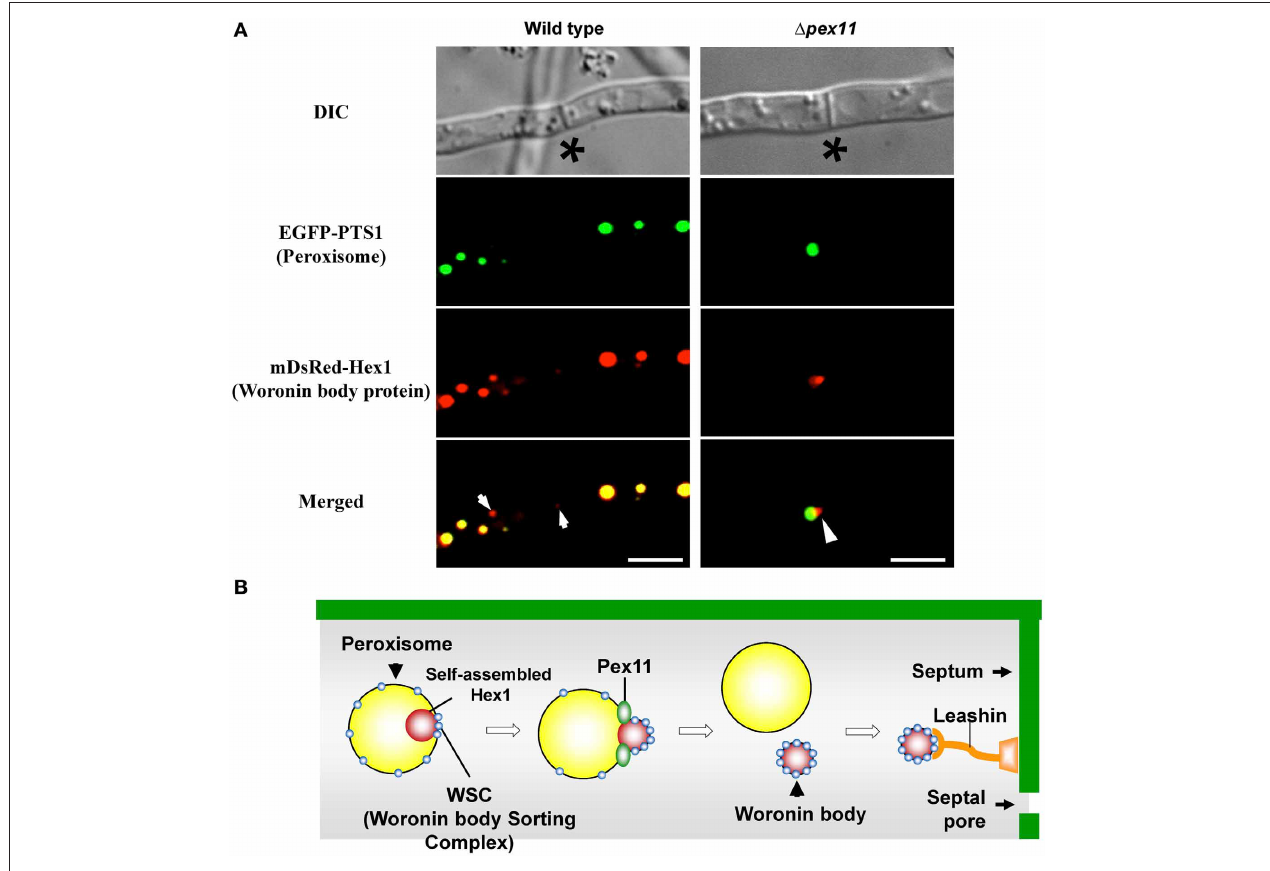
FIGURE 3 | Differentiation of the Woronin body from peroxisomes. (A) Fluorescence microscopic analysis of wild-type and (cid:2) pex11 strains of A. oryzae expressing EGFP-PTS1 and mDsRed-AoHex1 fusion proteins for visualization of peroxisomesand the major Woronin body protein, respectively